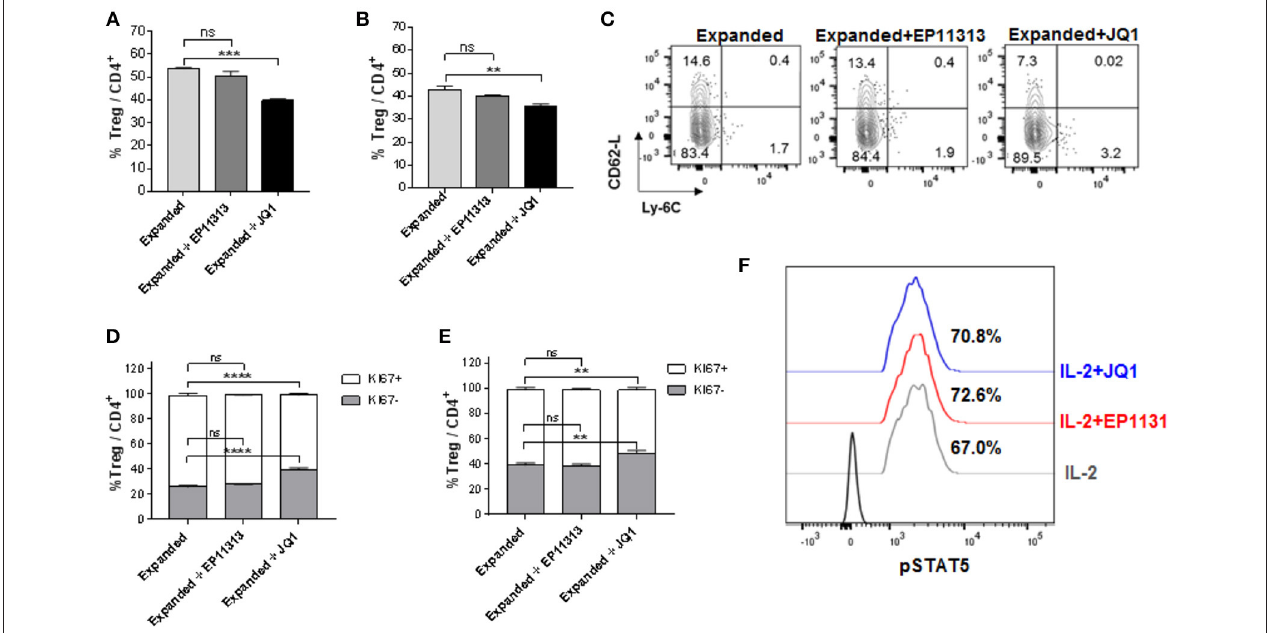
FIGURE 2 | In contrast to BETi EP11313, JQ1 alters Treg frequency, proliferation and subsets with no differences in pSTAT5 expression. (A–F) Mice were injected i.p. with TL1A-Ig and rmIL-2 bound to anti-IL-2 mAb as in Figure 1 and EP11313 (10 mg/kg), JQ1 (5–10 mg/kg) or vehicle (on days − 1 to 6). Mice were sacrificed on day 7. in vivo treatment with JQ1 significantly decreased overall Treg (CD4 + FoxP3 + ) frequency (%) of total CD4 + cells in the spleen (A) and pLN (B) . Representative contour plot of Treg subset distribution determined by CD62L and Ly-6C staining of pLN from mice undergoing Treg expansion treated with EP11313, JQ1, or vehicle. JQ1 treatment diminished cTreg CD62L hi Ly6C − (C) . Treg expanded proliferation was impaired with JQ1 in vivo treatment indicated by Ki67 expression in the spleen (D) and pLN (E) . (A–E) All results are representative of two independent experiments n = 3 mice/group. Representative histograms of lymph node cells from TL1A-Ig + IL-2 expanded mice treated in vitro with 500nM BETi or vehicle and stimulated with IL-2 10ng/ml for 15min (F) . ns, not significant. ** p < 0.01; *** p < 0.001; **** p < 0.0001 vs.